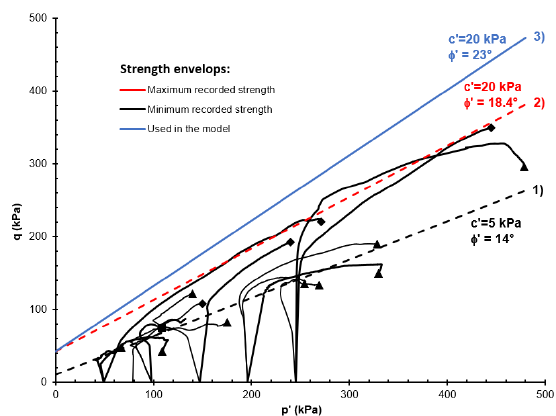
Figure 2. Undrained shear stress paths of Pisciolo clay samples (revisited after [3]) and shear strength envelopes: 1) minimum recorded strength; 2) maximum recorded strength; 3) used in the modelling.